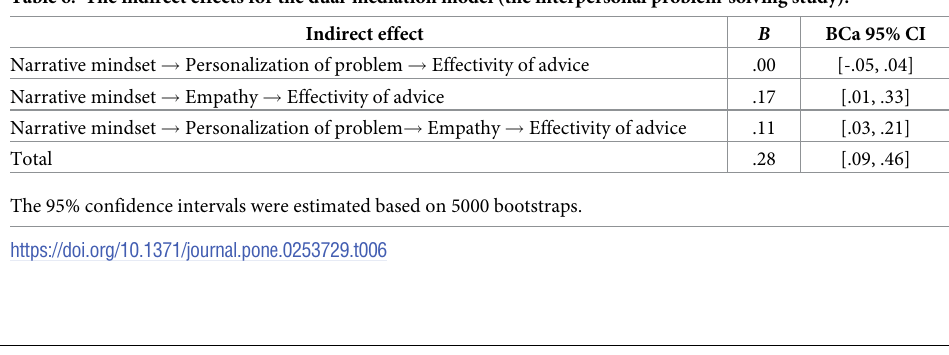
Table 6. The indirect effects for the dual-mediation model (the interpersonal problem-solving